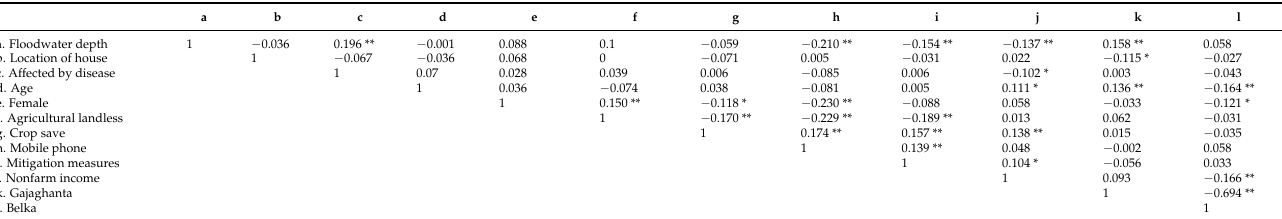
Table A3. Correlation Matrix of Explanatory